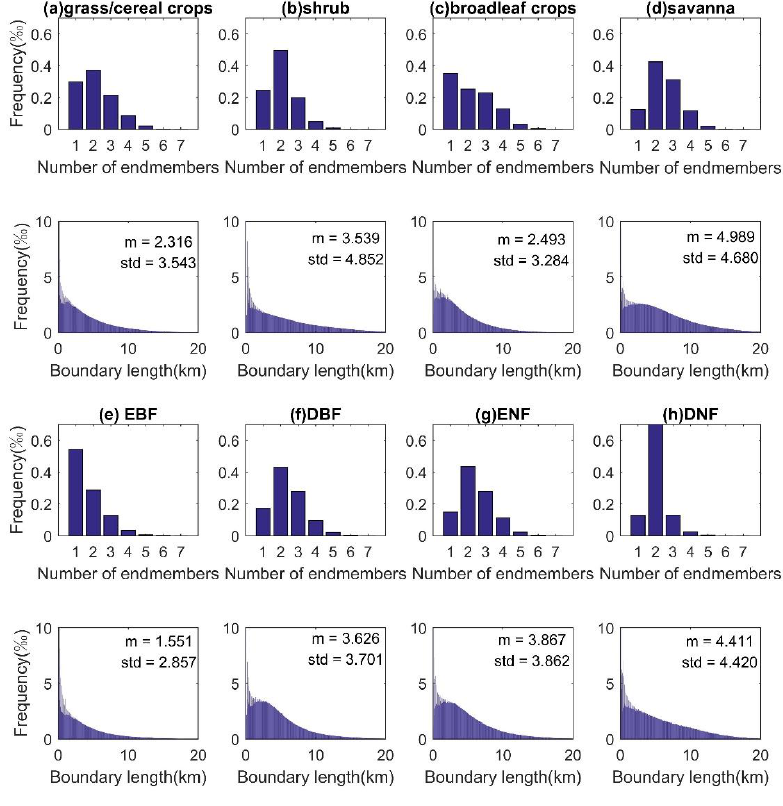
Figure 9. Frequency distributions of different endmember numbers and boundary lengths for different biomes (EBF, DBF, ENF, and DNF stand for evergreen broadleaf forest, deciduous broadleaf forest, evergreen needleleaf forest, and deciduous needleleaf forest,